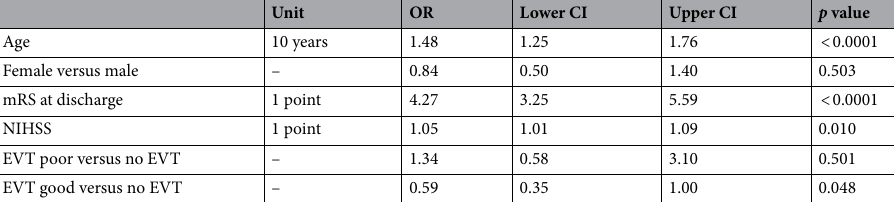
Table 4. Multivariable logistic regression analysis for 90-day mortality. OR Odds ratio, CI Confidence interval (Wald), mRS Modified Rankin Scale score, NIHSS National Institute of Health Stroke Scale, EVT poor EVT with thrombolysis in cerebral infarction score 0–2a, EVT good EVT with thrombolysis in cerebral infarction score